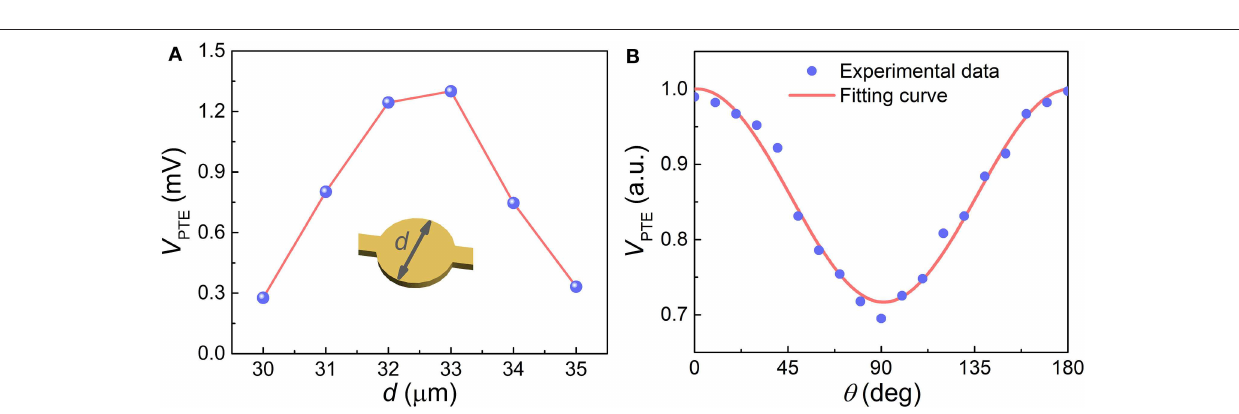
fitted line, we can obtain the photovoltage responsivity,